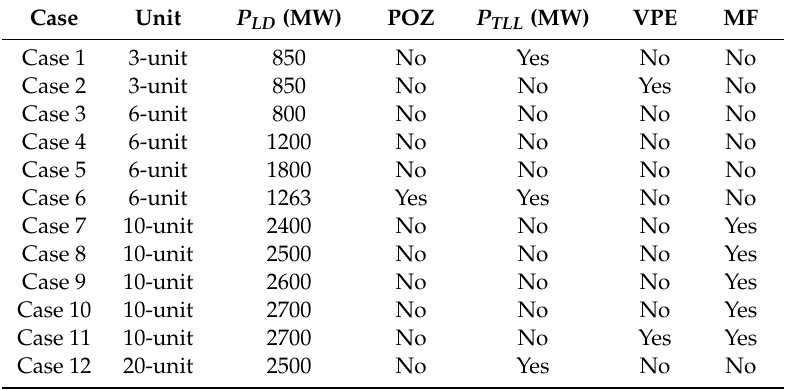
Table 1. Summary of twelve study cases.